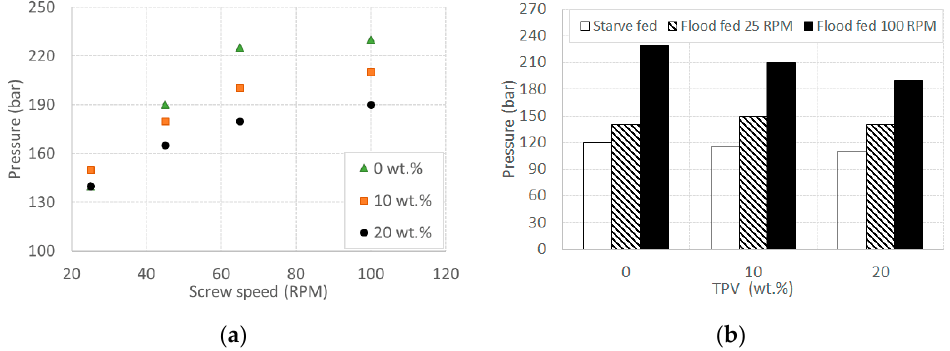
Figure 1. Die pressure ( a ) vs. screw speed for all materials in a flood fed condition at different screw speeds and ( b ) vs. thermoplastic vulcanizate (TPV) content in a starve fed condition at 100 RPM, flood fed condition at 25 RPM, and flood fed condition at 100 RPM.